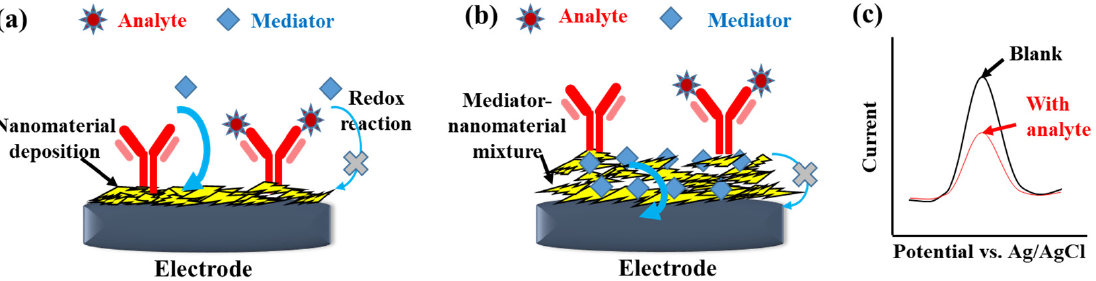
Figure 3. Scheme of detection mechanism of the label-free electrochemical immunosensors with me- diators spiked in the electrolyte ( a ) or the modification layer ( b ). ( c ) The illustration shows the de- crease of peak current with the analyte immunoreaction when performing DPV or SWV measure- ment.